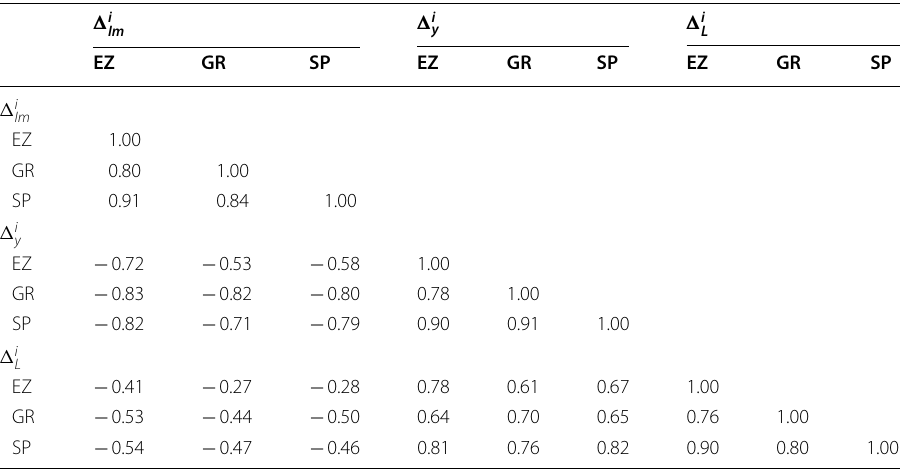
Table 3 Correlation matrix between output, import and total employment